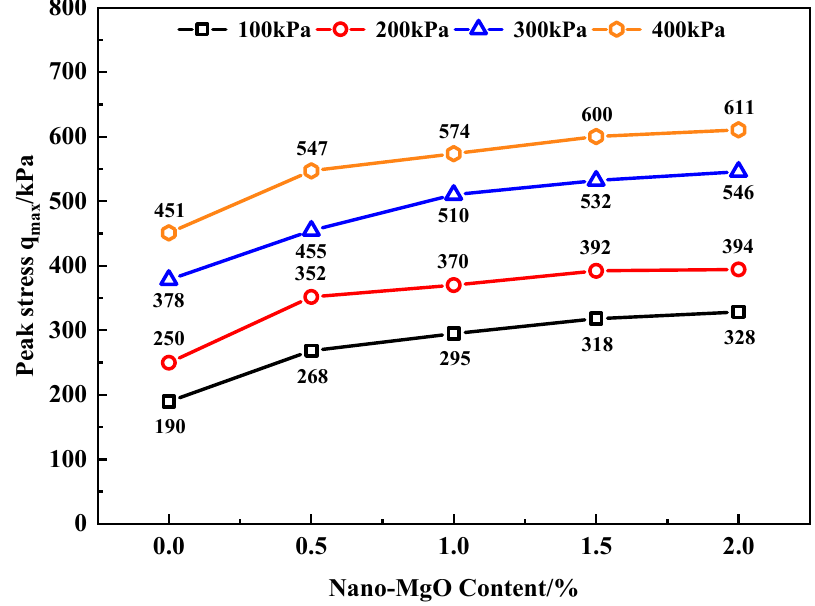
Figure 3. The relationship between peak stress and normal stress of MCRA.